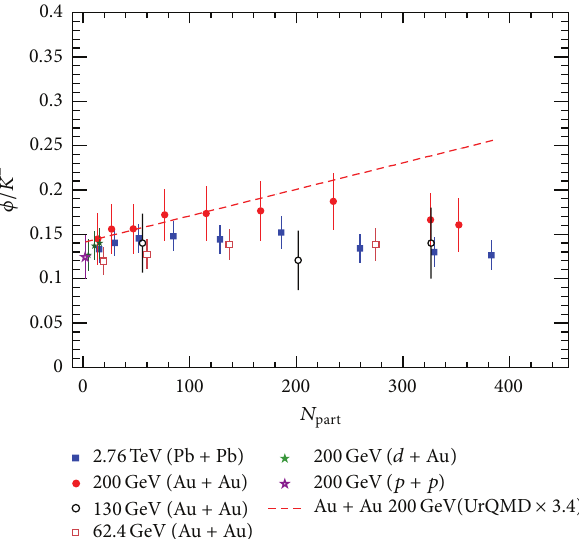
Figure 7: ⟨𝑚 𝑇 ⟩−𝑚 0 as a function centre-of-mass energies in central A + A and 𝑝 + 𝑝 collisions. Only statistical errors are shown. The dashed and solid lines are the straight lines connected to the data to guide the eye of the reader.